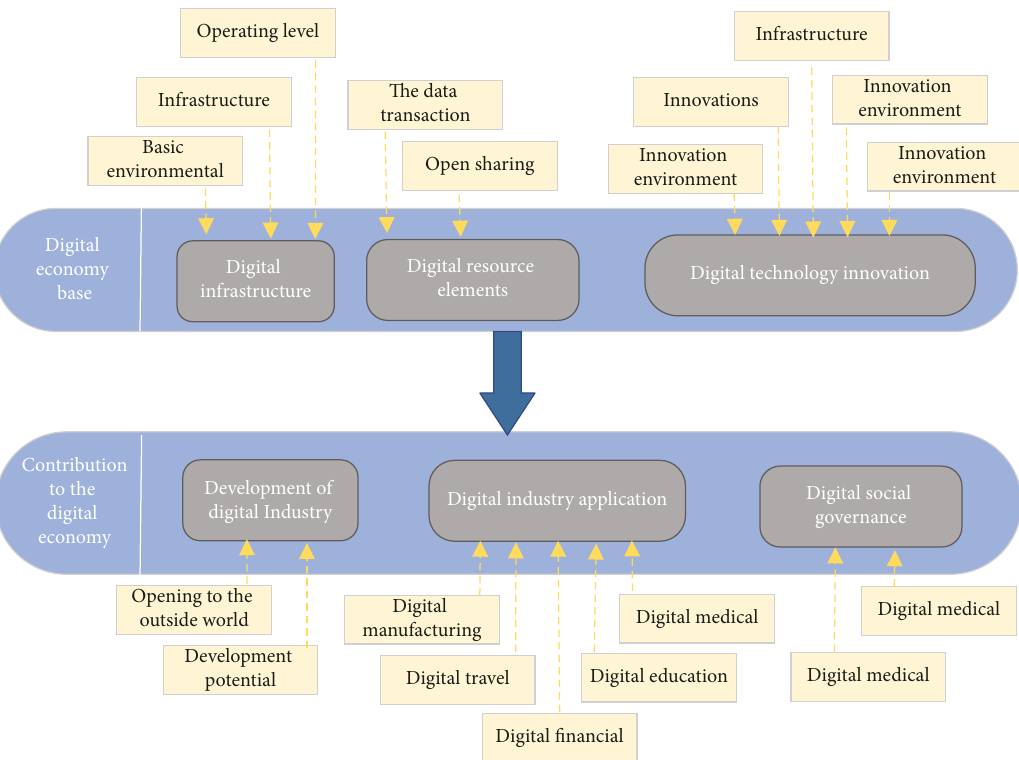
Figure 1: Theoretical framework of digital economy